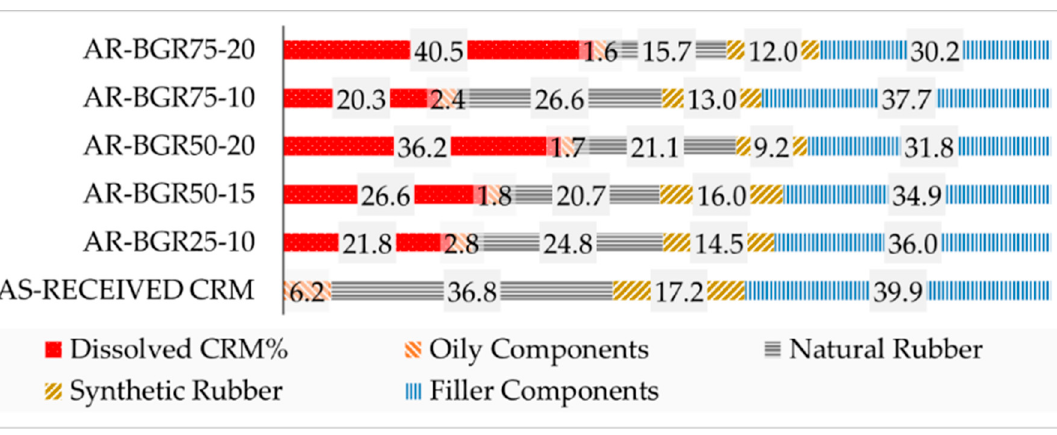
Figure 10. Four major components of the extracted CRM and the dissolved amount in binder regarding the five selected binders and the as-received CRM.